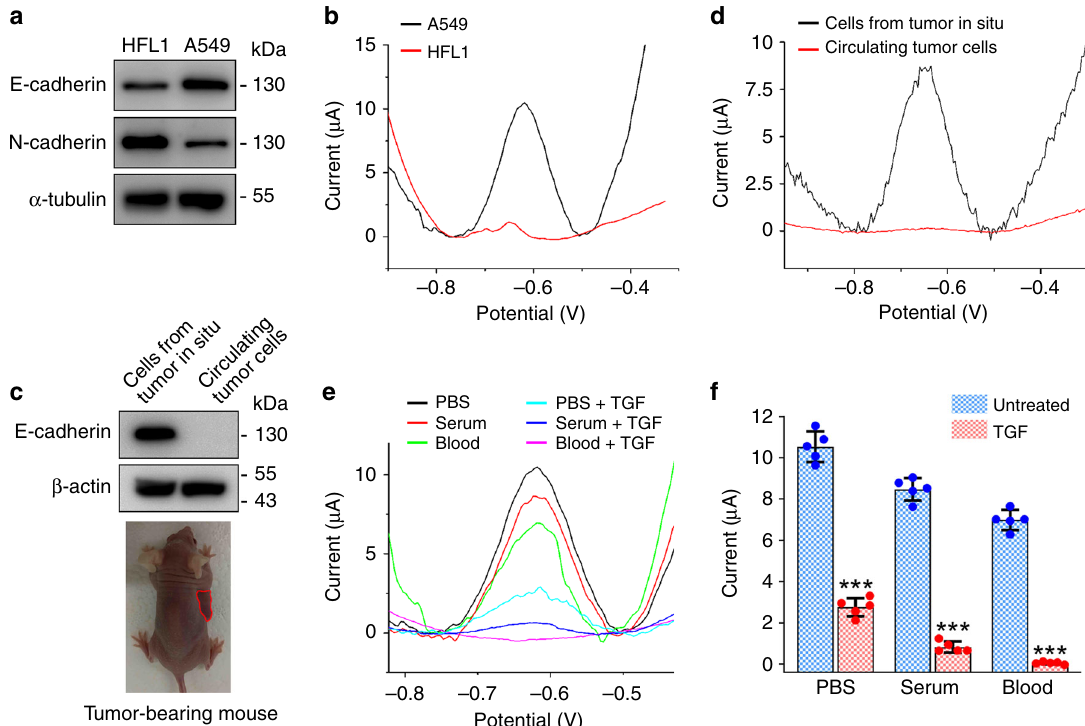
Fig. 6 Examination of the practicability of the EMT biosensor. a Immunoblot analysis of HFL1 and A549 cells with E-cadherin, N-cadherin, and α -tubulin antibodies. b Electrochemical detection of HFL1 and A549 cells with the EMT biosensor. c , d Immunoblot analysis of E-cadherin and β -actin c and DPV measurement d using cells from tumor in situ and circulating tumor cells. e Electrochemical detection of E-cadherin using A549 cells in PBS, fetal calf serum, and mouse blood. f Experiments were performed as in e , and the peak currents were then analyzed. *** p < 0.001 by Student ’ s t test. Error bars represent ± s.d. ( n = 5). Source data are provided as a Source Data fi